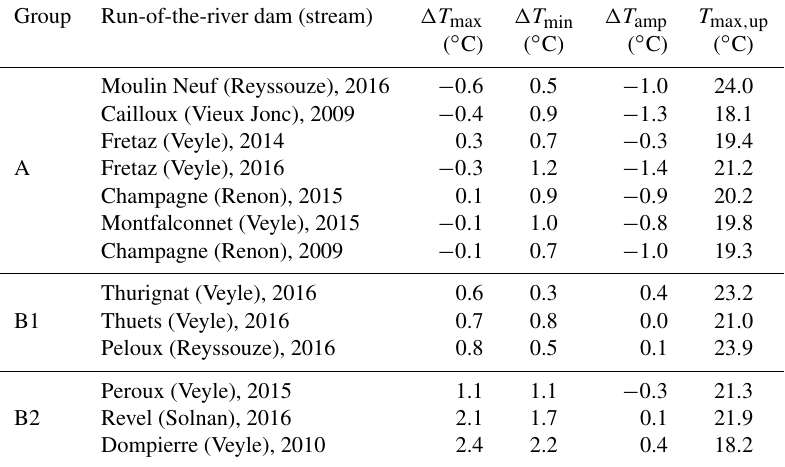
Table 3. Median values of differences between daily maximum ( (cid:49)T max ) and minimum temperatures ( (cid:49)T min ) and the diurnal ranges ( (cid:49)T amp ) between upstream and downstream regions of the run-of-the-river dams. The daily maximum upstream temperature ( T max , up ) is indicated to show the limited influence of the initial temperature on upstream–downstream differences.